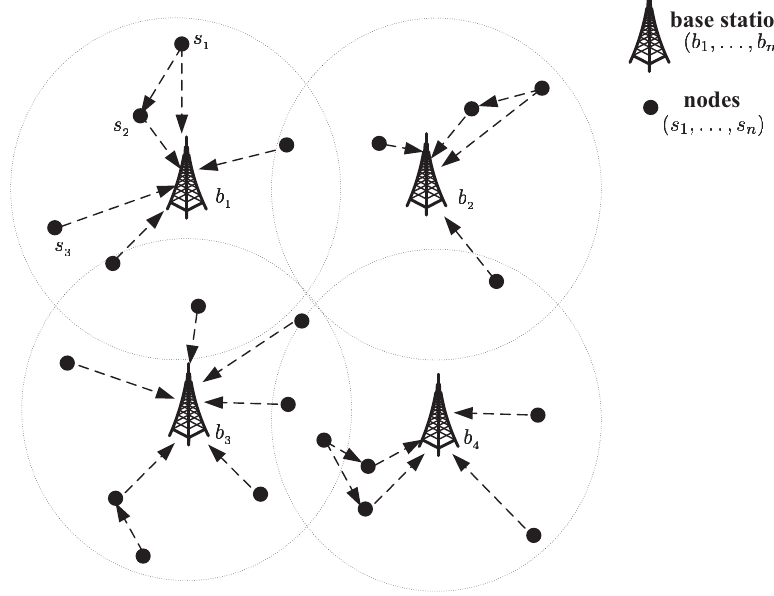
Figure 2. Topological structure of a multi-hop random